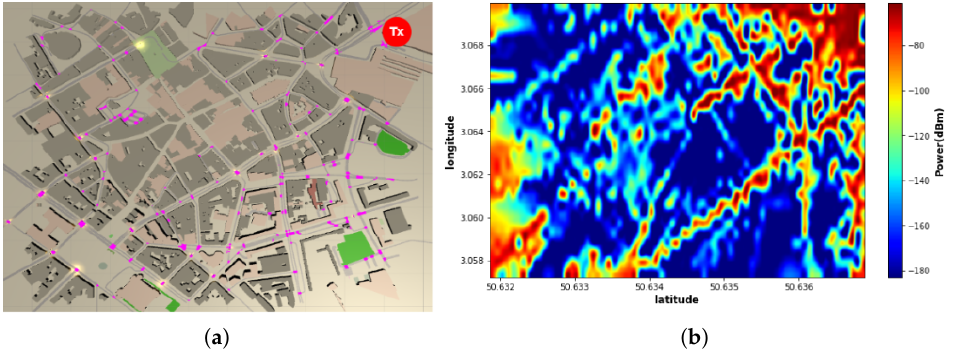
Figure 2. RF-EMF exposure reference map: ( a ) Transmitter’s location corner; ( b ) Transmitter at upper right corner.